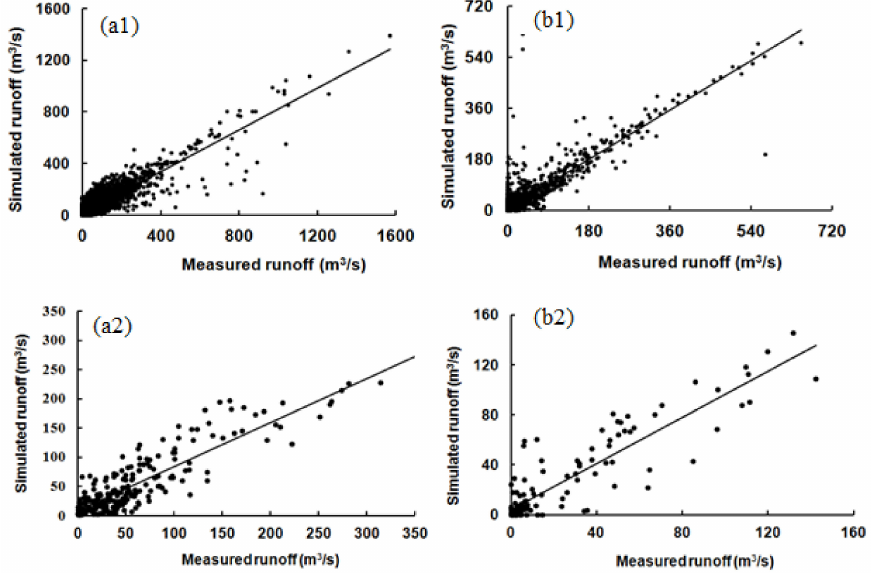
Figure 7. Fitting relationship between the daily simulated runoff and measured runoff: ( a1 ) Cal- ibration period and ( b1 ) Verification period; the monthly simulated runoff and measured runoff: ( a2 ) Calibration period and ( b2 ) Verification